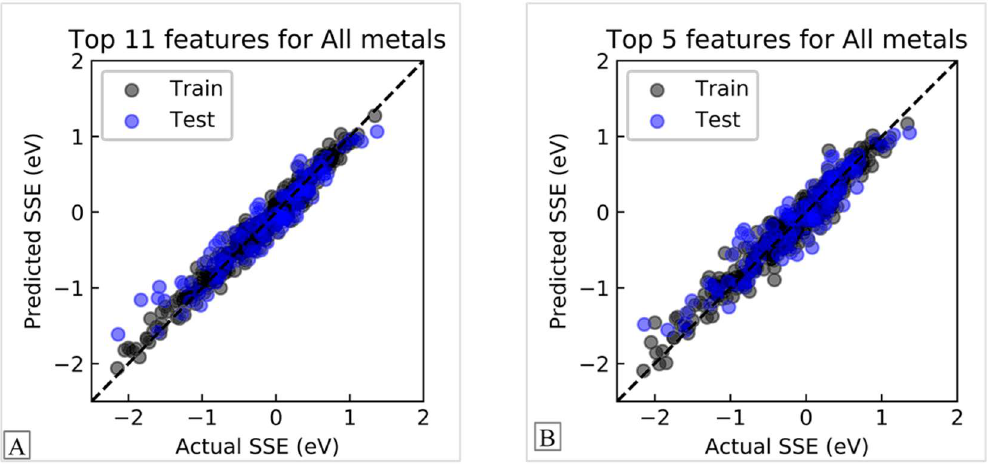
Figure 9. GBR model predictions for combined [FCC (111) + BCC (110) + HCP (001) surfaces] dataset using ( A ) 11 features and ( B ) 5 features. SSE = surface segregation energy.